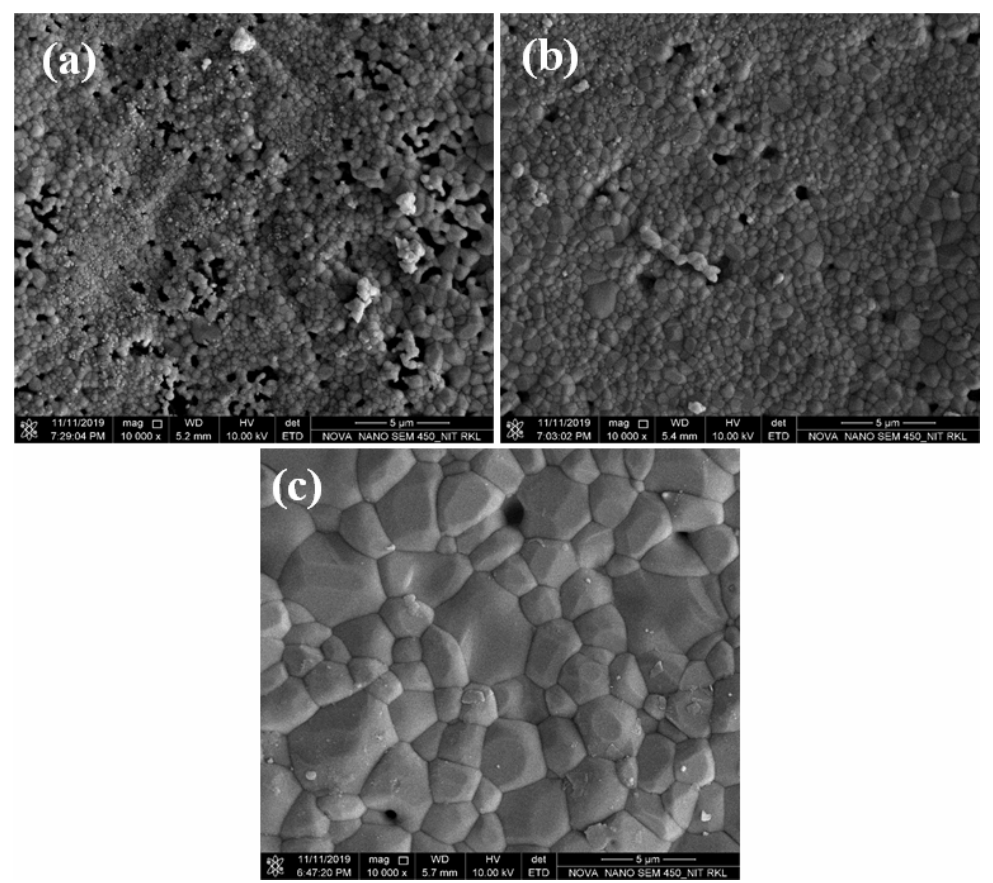
Figure 4. FESEM images of HAp samples sintered at ( a ) 1200 °C, ( b ) 1250 °C, and ( c ) 1300 °C. Table 1. Variation of mechanical properties with sintering temperature of HAp